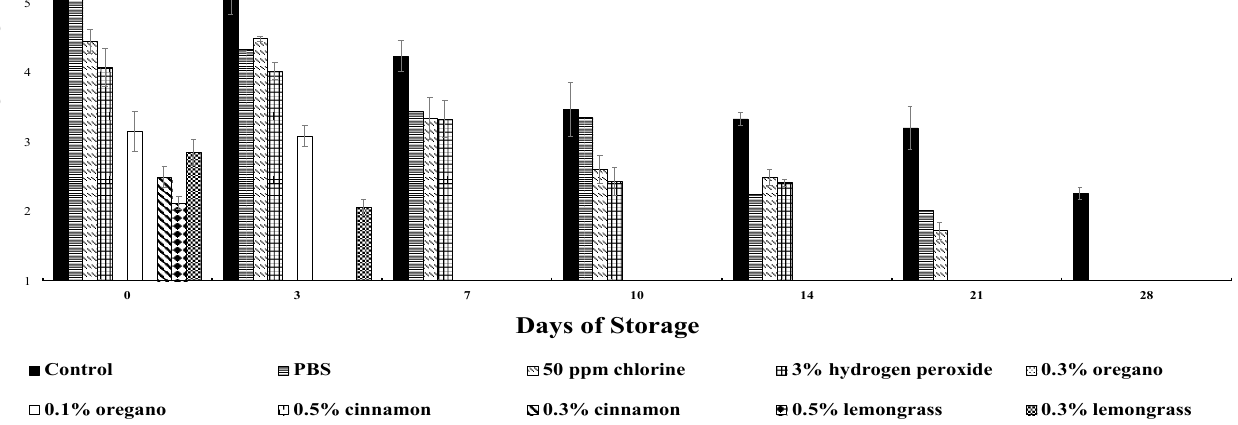
Figure 1. Survival of E. coli O157:H7 on Iceberg lettuce treated with 0.3 and 0.1% oregano; 0.5 and 0.3% cinnamon; and 0.5 and 0.3% lemongrass oil microemulsions for 2 min and stored at 4 °C for 28 days. All values are an average of three repeats. Error bars represent the standard deviation from the mean value.